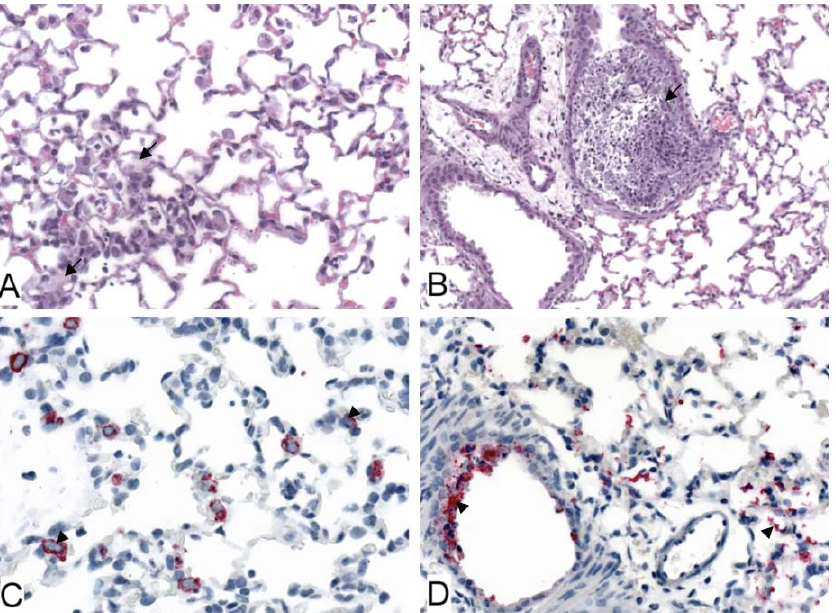
Figure 6. Histopathology and Immunohistochemical Localization of SARS-CoV Antigens in the Lungs of Mice Infected with MA15 Virus Abundant necrotic cellular debris (arrows) in alveoli (A) and a bronchiole lumen (B) of mice at days 2 and 3 p.i., respectively. Abundant SARS-CoV antigens (arrowheads) within alveolar pneumocytes (C) and in necrotic alveolar and bronchiolar cellular debris in mice at day 2 p.i. (D). (A and B) Hematoxylin and eosin stain; (C and D) primary antibody, rabbit anti-SARS-CoV antibody; secondary antibody conjugated with alkaline phosphatase with naphthol fast-red and hematoxylin counterstain; original magnifications 3 100. Mice were inoculated with 10 5.6 TCID 50 MA15 virus/mouse.